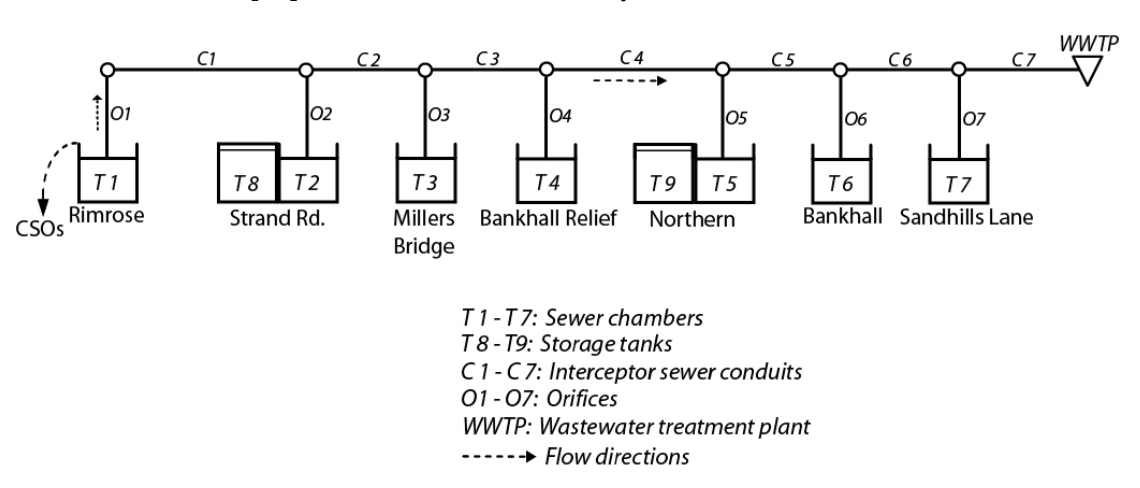
Figure 2. Interceptor sewer